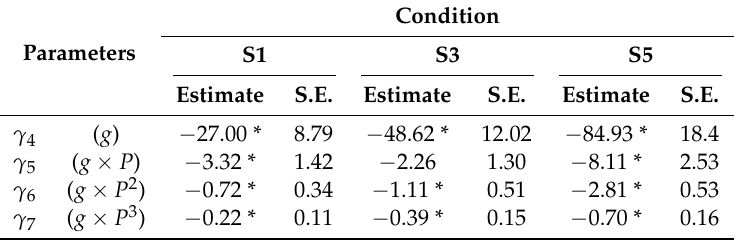
Table 4. Parameters estimating the WPR within the MLM approach with unstandardized regression weights. Condition S1 S3 S5Parameters Estimate S.E. Estimate S.E. Estimate S.E. γ 4 ( g ) − 27.00 * 8.79 − 48.62 * 12.02 − 84.93 * ( g × P